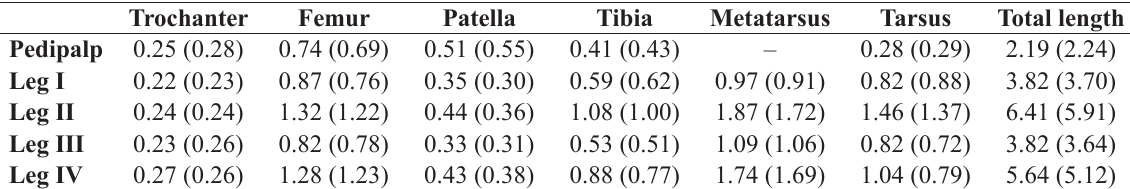
Table 9. Length of appendage-segments in millimeters in N. kozari Novak, Kozel, Podlesnik & Raspotnig sp. nov. from Vlašić planina, Bosnia and Herzegovina: ♂ holotype